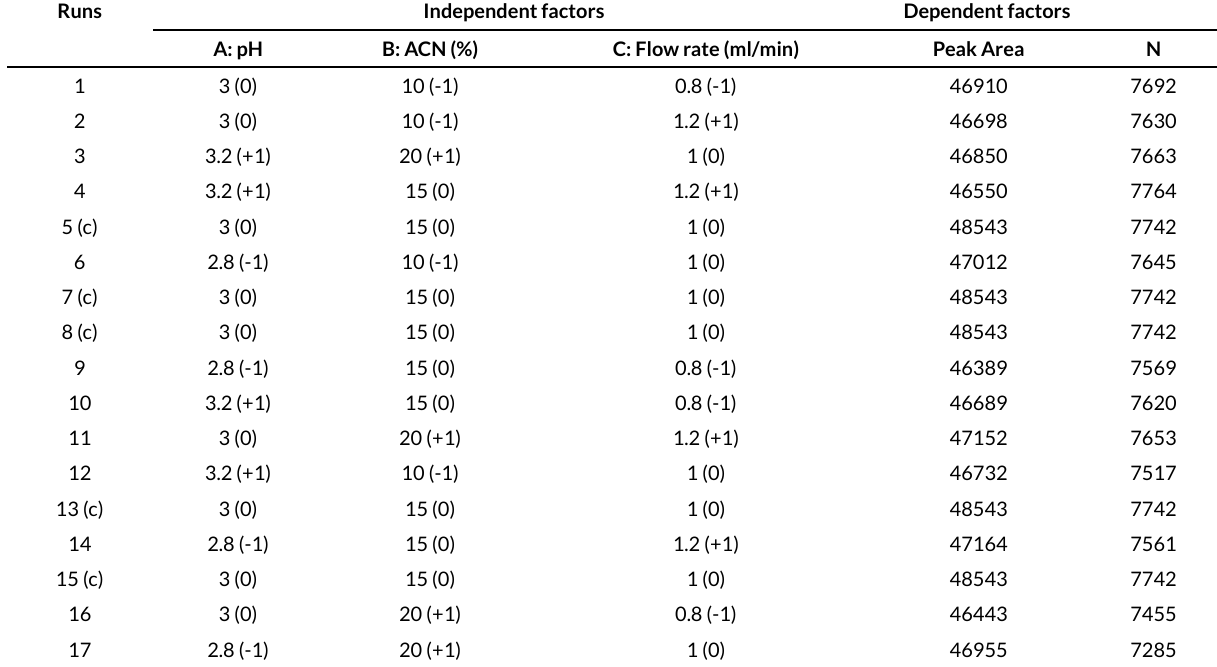
Table 2. The three-level factorial summary includes independent variables and their responses.